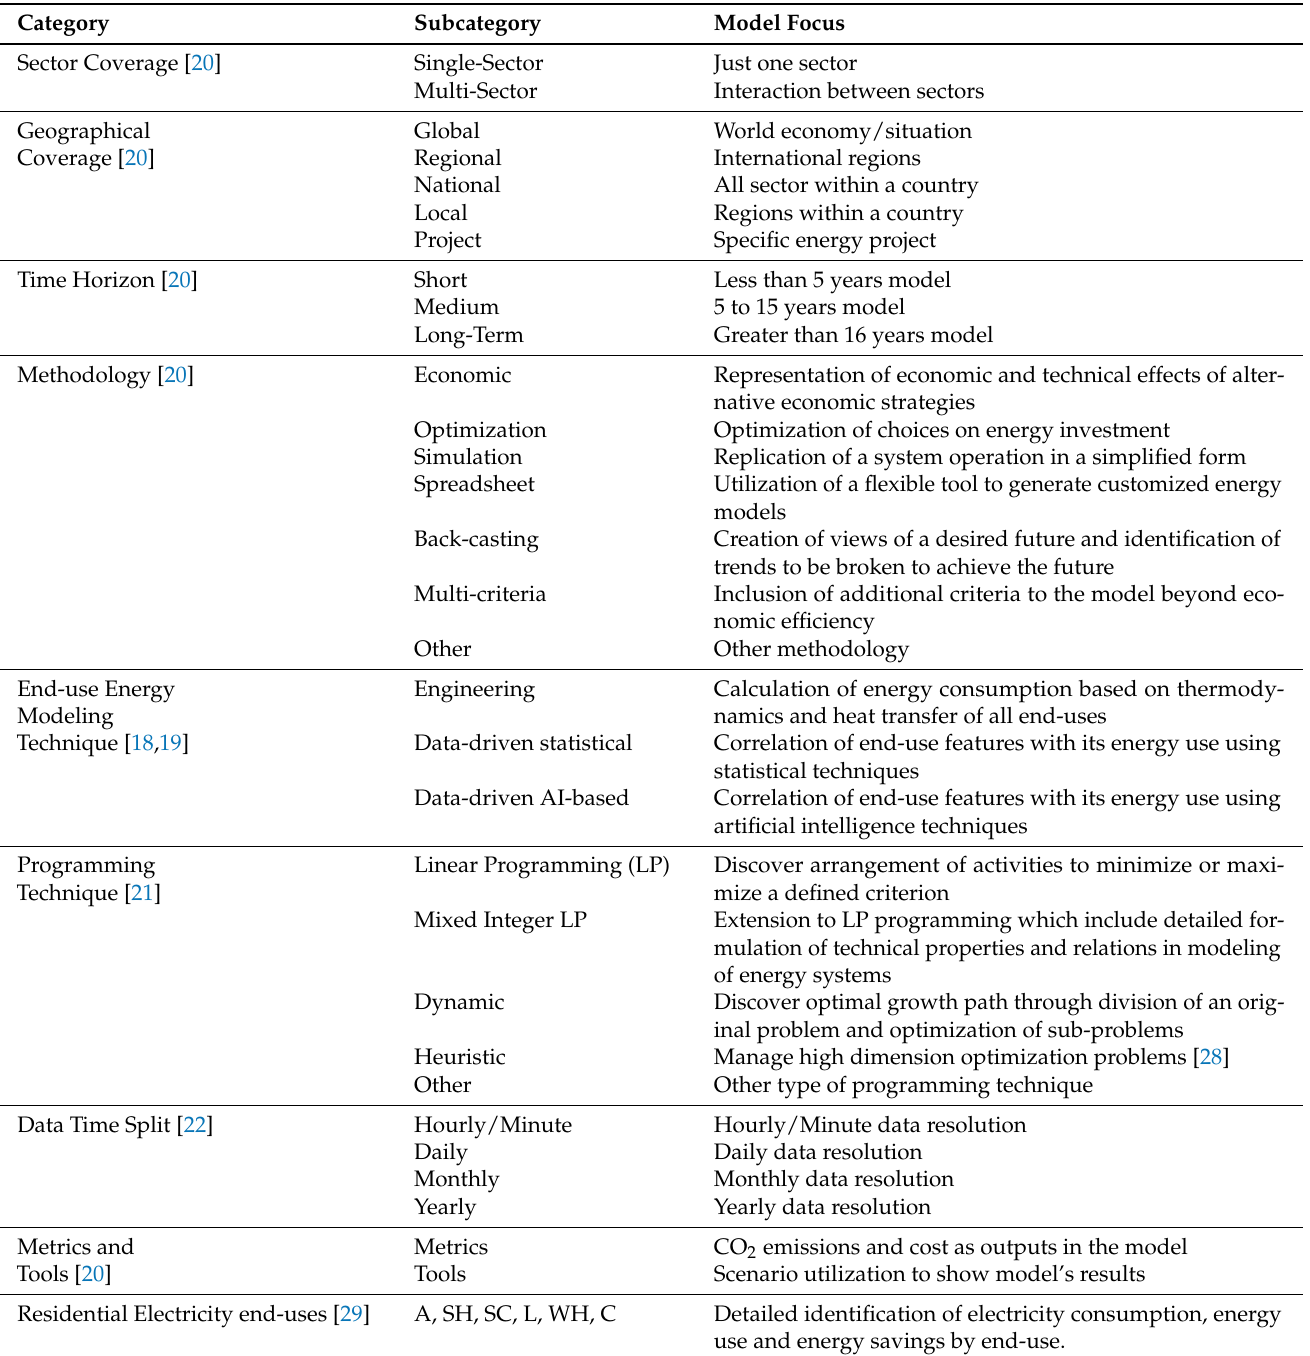
Table 2. Taxonomy of Bottom-up Energy